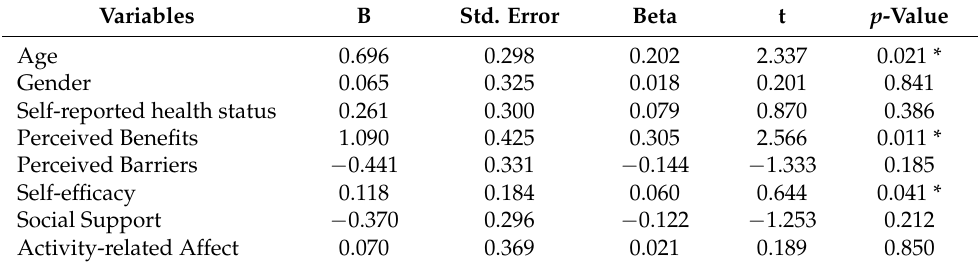
Table 3. Multiple regression analysis model examining predictors associated with participation in community-based health promotion activities ( N =